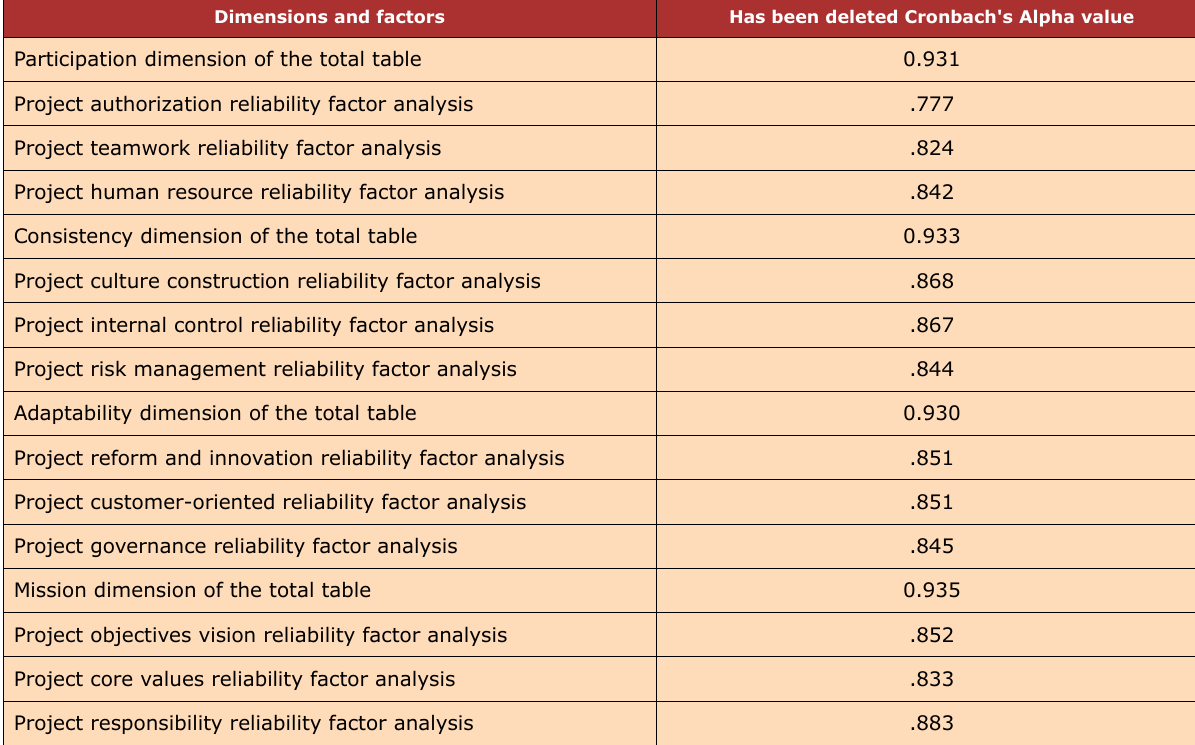
Table 3. Project cultural evaluation dimensions and Cronbach Alpha coefficient of